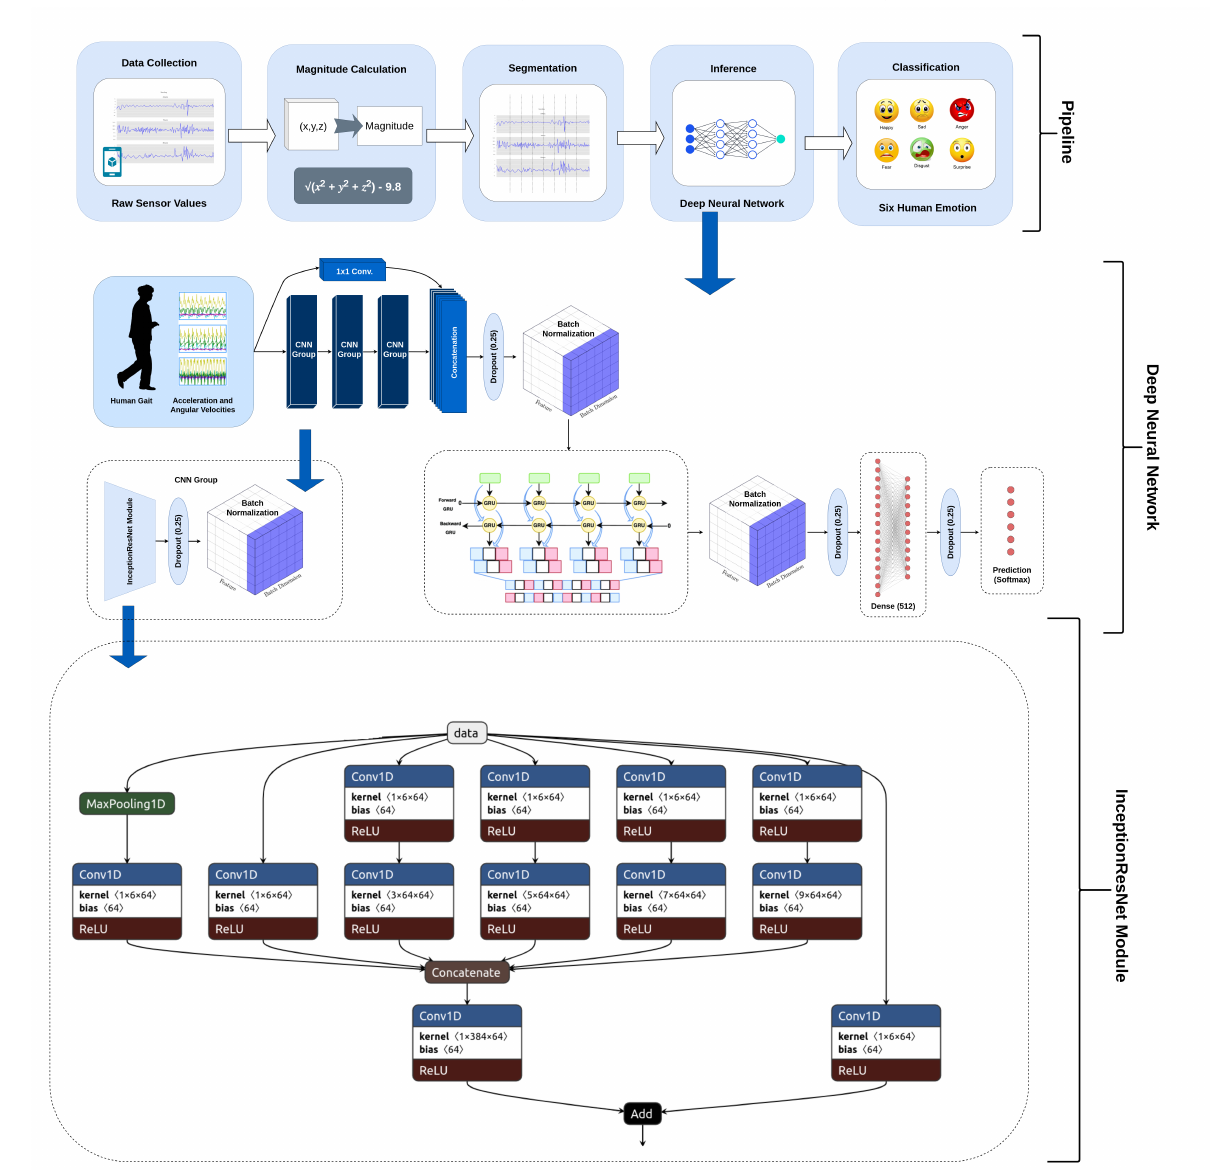
Figure 3. The end-to-end pipeline of the presented approach. The raw sensors data are segmented. The magnitude feature is computed and used for training and inference of the presented